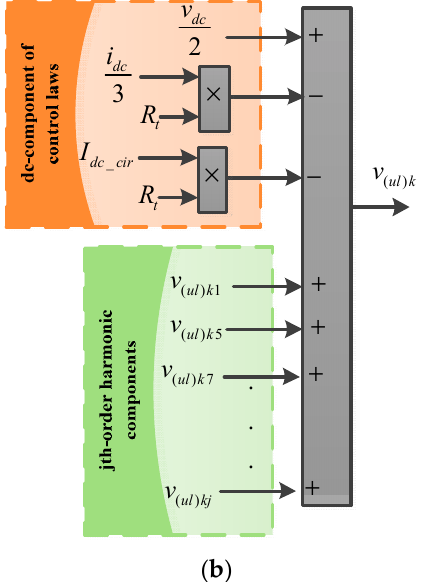
Figure 3. Proposed control strategy under circulating currents with a dc component and second-order frequency sinusoid: ( a ) harmonic components of control laws and ( b ) the control laws.